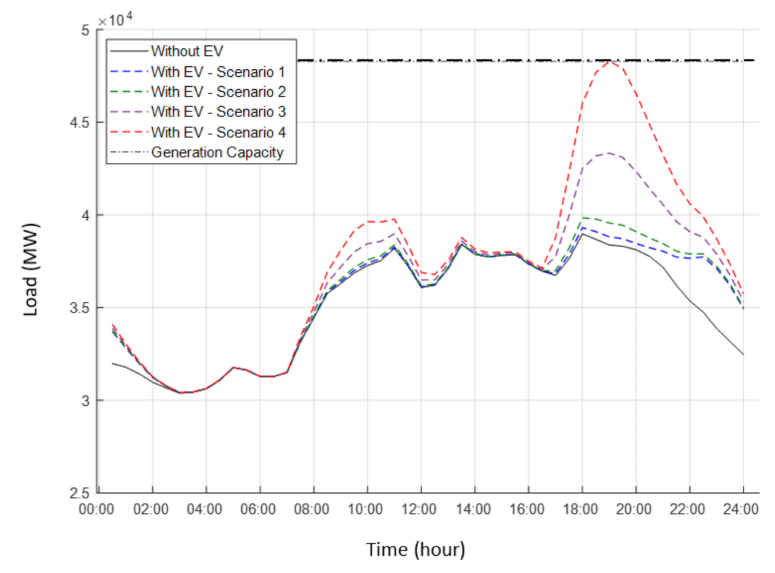
Figure 4. Java-Bali forecasted load profile with various EV integration scenarios with uncoordinated charging.